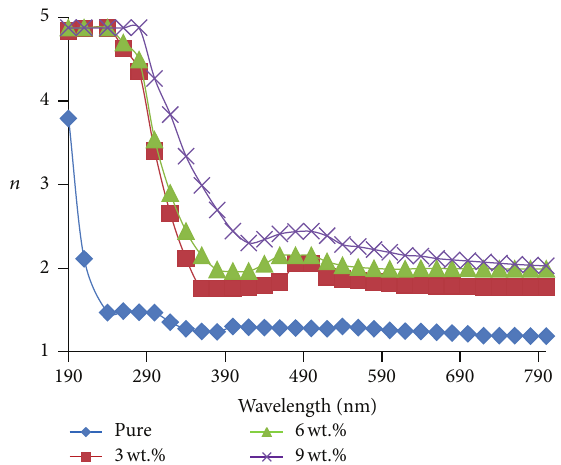
Figure 12: Refractive index of PVAc/0, PVAc/3, PVAc/6, and PVAc/9 wt.% of [Co(NH 3 ) 5 Cl]Cl 2 composites versus wavelength. Figure 13: Real part of dielectric constant of PVAc/0, PVAc/3,